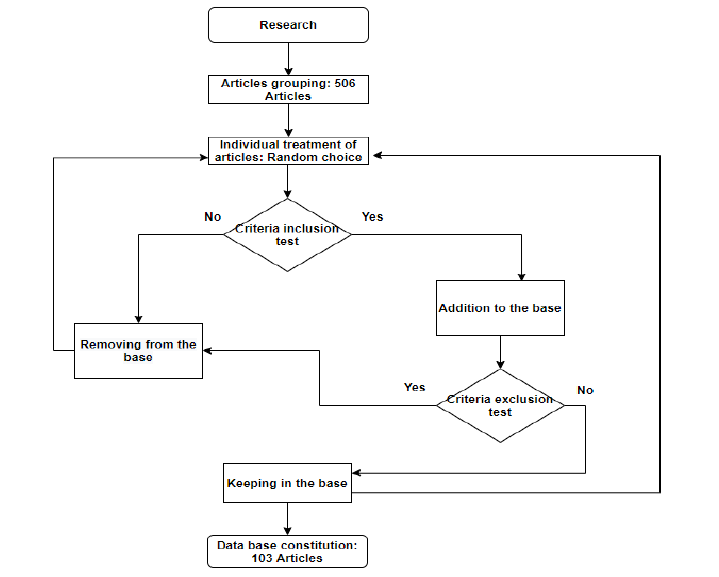
Figure 1: Flowchart detailing the stages in the constitution of the article database